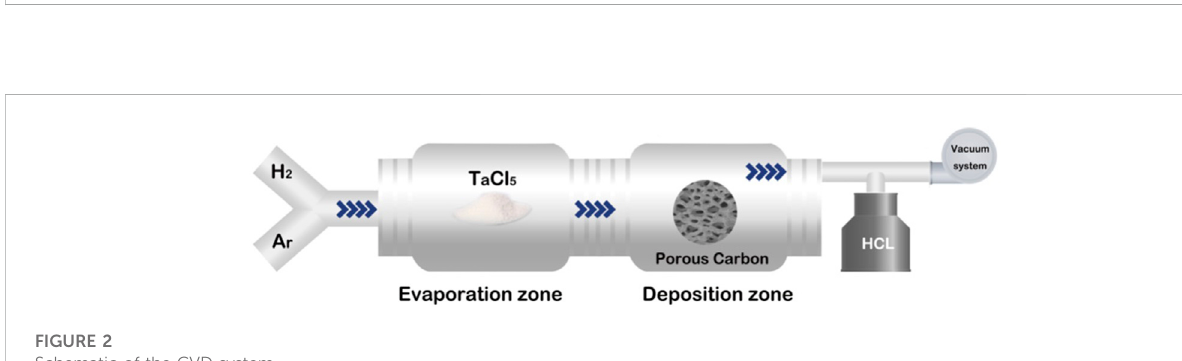
Schematic of the powder metallurgy technique (Rupérez et al., 2015). Copyright © 2015 Published by Elsevier Ltd.